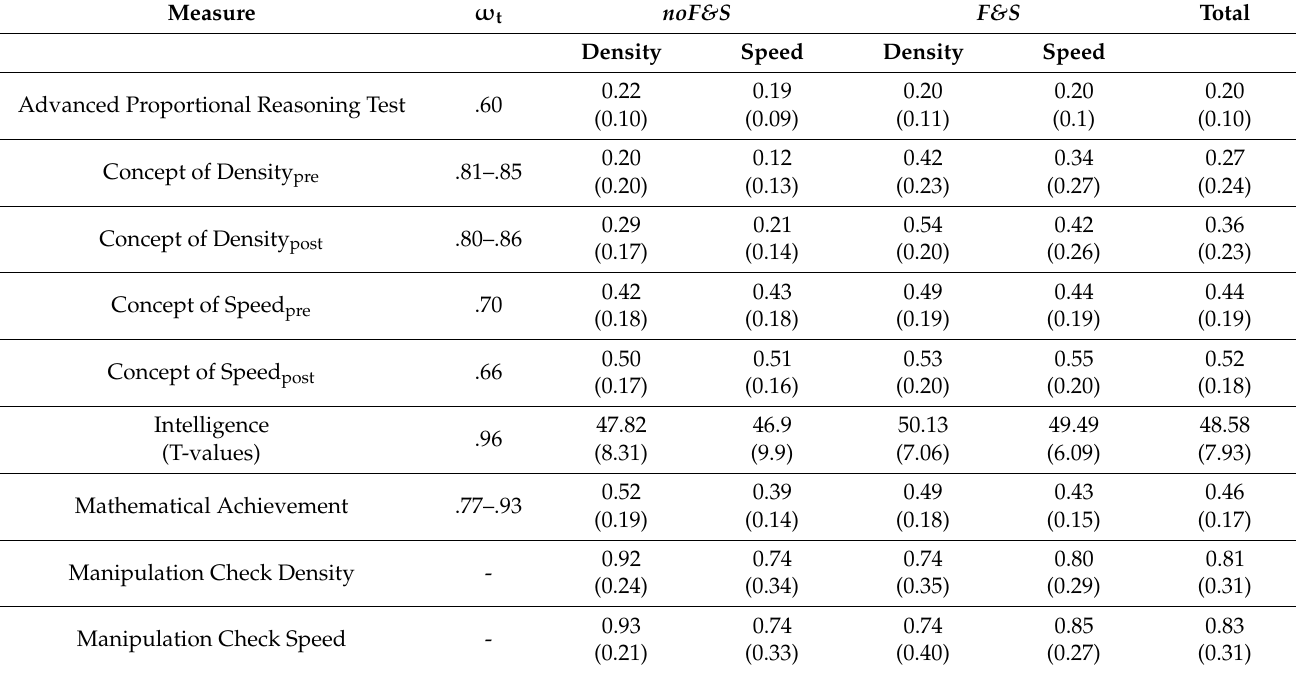
Table 1. Mean solution rate per group and for total sample in Study